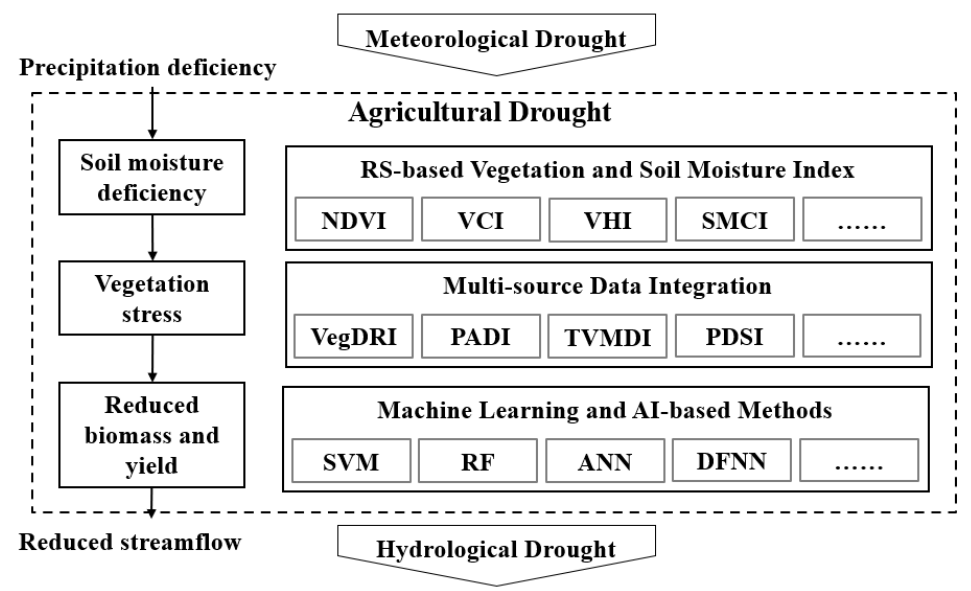
Figure 2. EO-based agricultural drought monitoring and assessment.